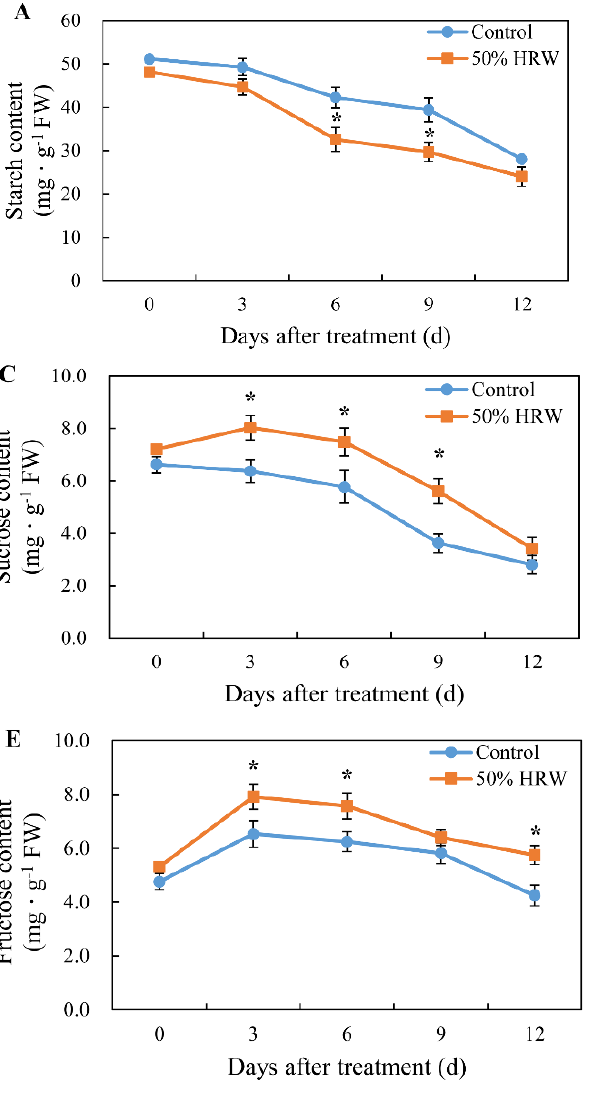
Figure 5. Changes in the content of starch ( A ); water-soluble carbohydrate ( B ); sucrose ( C ); glucose ( D ) and fructose ( E ) in Lanzhou lily scales with or without 50% HRW treatment during storage at room temperature for 12 days. Values are the mean ± SE of three independent experiments. The asterisks denote T -test significance between the control and 50% HRW treatment on the same day: * p < 0.05. HRW: hydrogen-rich water.